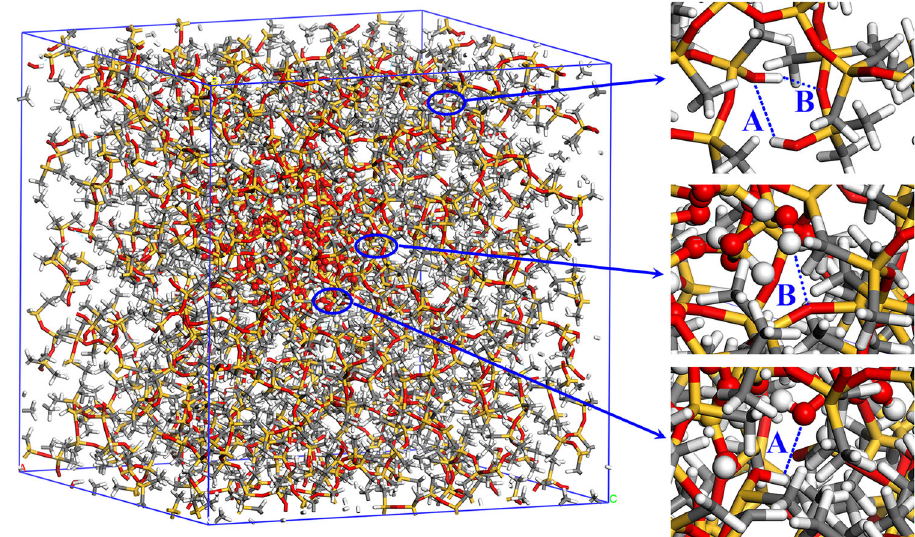
Fig. 3 The types of H-bonds in the Model 3 system.